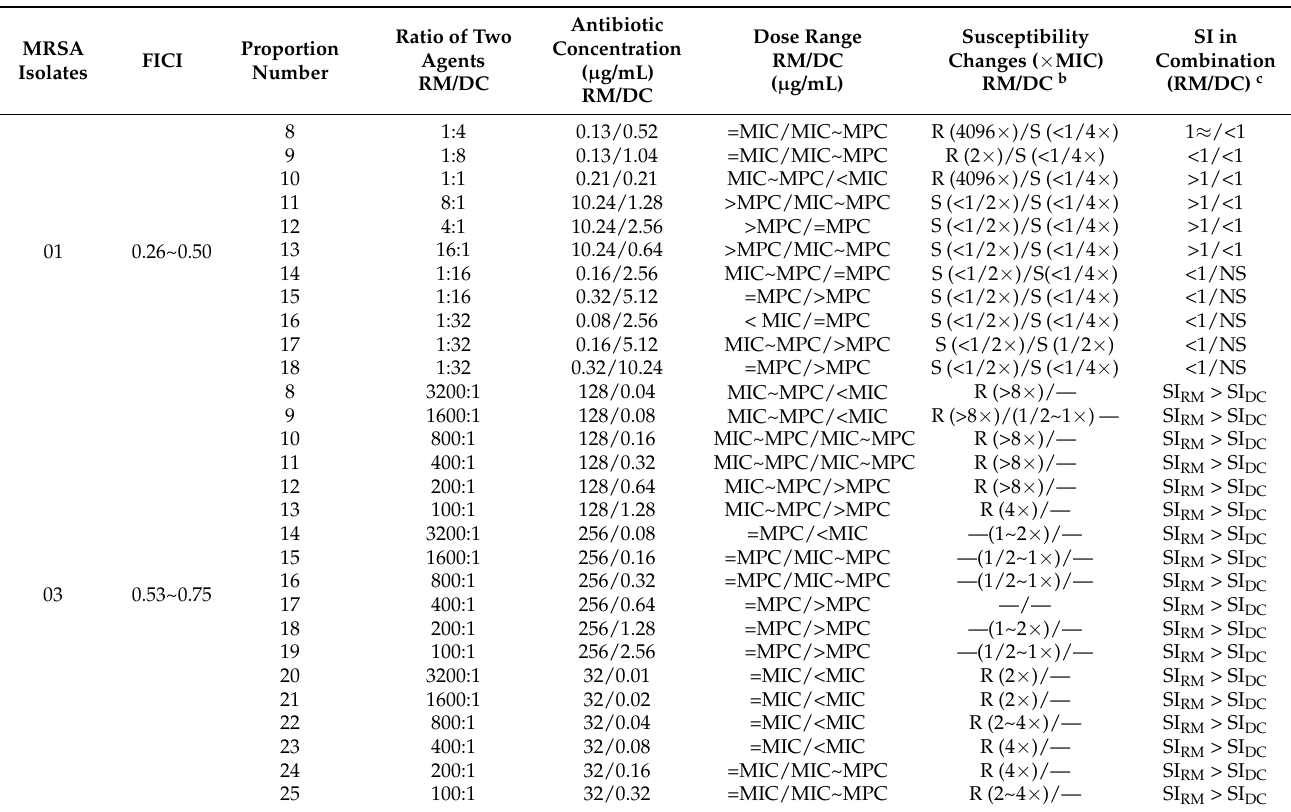
Table 7. Susceptibility changes of MRSA isolates to two agents after exposed to various proportions of combination roxithromycin/doxycycline (RM/DC) with different concentrations a